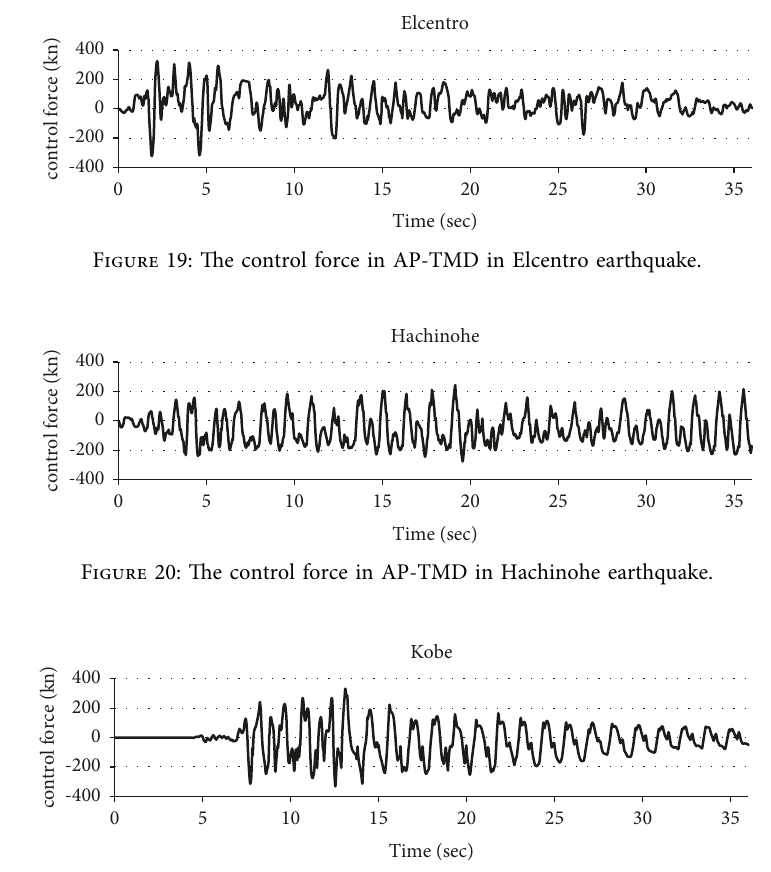
Figure 21: The control force in AP-TMD in Kobe earthquake.